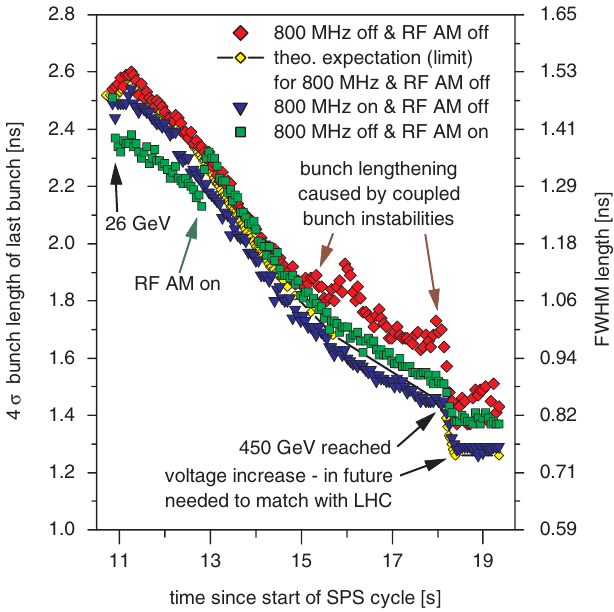
FIG. 13. (Color) Bunch length development of last